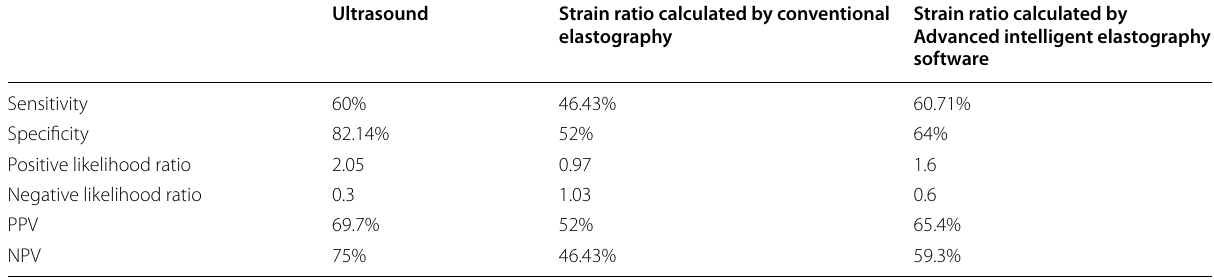
Table 1 Comparison of Ultrasound, Conventional elastography, and advanced intelligent software diagnostic indices